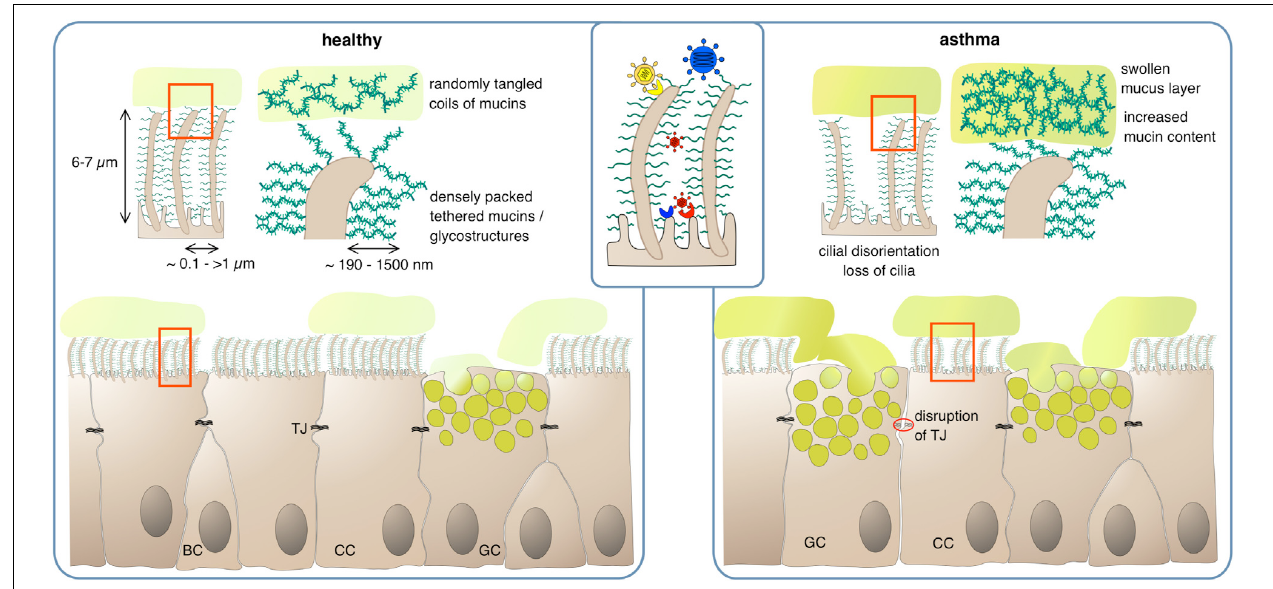
FIGURE 1 | Protection of epithelial surfaces by physical barriers. In the healthy state, ciliated cells (CC) form a tight epithelial layer where paracellular passage is prevented by sealing of lateral intercellular spaces with tight junctions (TJ). The apical epithelial cell surface, including the cilia, is covered by a layer of membrane-anchored glycoproteins and glycolipids, the glycocalyx. The dense meshwork of glycostructures restricts access of luminal matter to the apical cell surface; depending on their size, larger pathogens can be cut off from their receptor if it is not present on cilia (inset). Goblet cells (GC) secrete mucus, consisting of highly glycosylated mucins which absorb large quantities of water to form a viscous gel. The mucus – and any matter trapped within – is transported upward in the airway lumen by the coordinated beating of the cilia. BC, basal cells. In the asthmatic state, barrier functions can be compromised by partial disruption of tight junctions and gaps in the PCL/glycocalyx meshwork due to loss of cilia. Mucus clearance is impeded by increased mucus viscosity and swelling of the gel matrix, and by disturbance of ciliar beating due to disorganization and dykinesia of